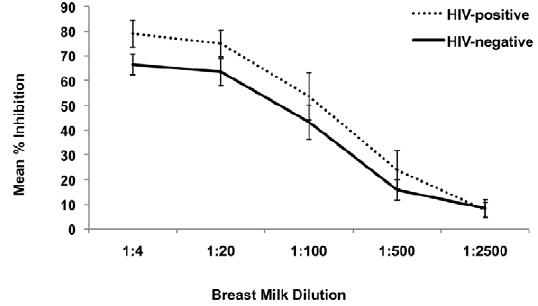
Figure 1. Inhibition of cell-free HIV-1 by breast milk. Mature breast milk from HIV-positive (n=8) and HIV-negative (n=8) donors was evaluated for inhibition of cell-free HIV-1 in TZM-bl cell assays. Cells were infected with R5 HIV-1 BaL in the presence of five-fold serial dilutions of breast milk. Percent inhibition was calculated relative to control cultures infected with HIV-1 BaL in the absence of added breast milk. HIV-inhibitory activity of breast milk from HIV-positive (dotted line) and HIV-negative (solid line) donors is shown (mean 6